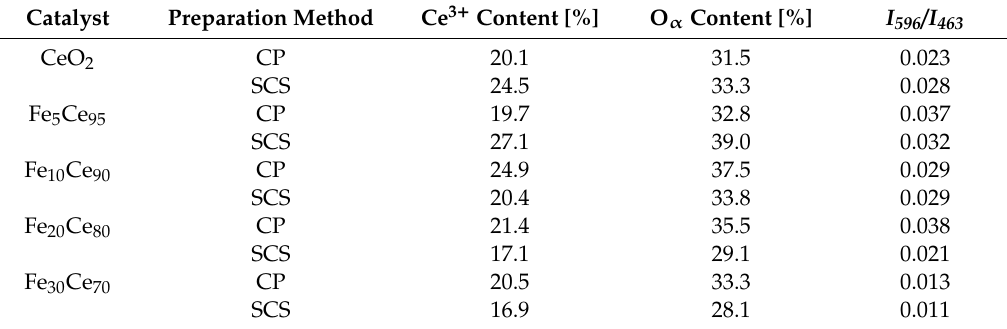
Figure 3. XPS spectra of Ce3d: ( a ) Co-precipitation method, ( b ) solution combustion synthesis method.